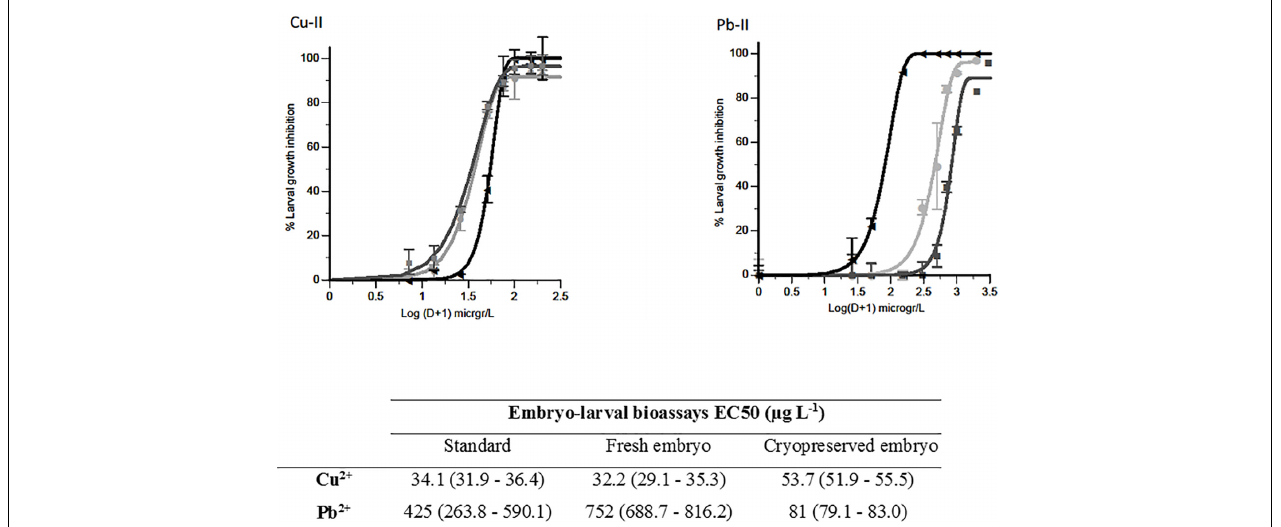
FIGURE 1 | Copper and lead toxicity tests. Larval growth inhibition at each concentration ± SD ( n = 35). Light gray, dark gray, and black represent the standard bioassay, the fresh embryo bioassay and cryopreserved embryo bioassay, respectively. Table attached shows EC50s ( µ g L − 1 ) and 95% confidence intervals (in brackets). Figures modified from Paredes and Bellas